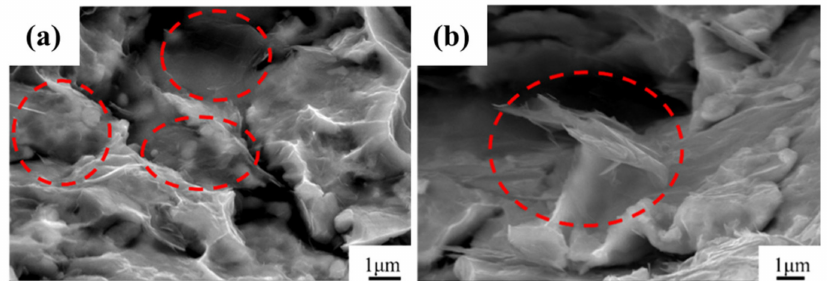
Figure 14. Fracture morphology of composites. ( a ) Fracture analysis of composites made by BM10h, ( b ) Fracture analysis of composites made by 1000 ◦ C CVD-BM10h.